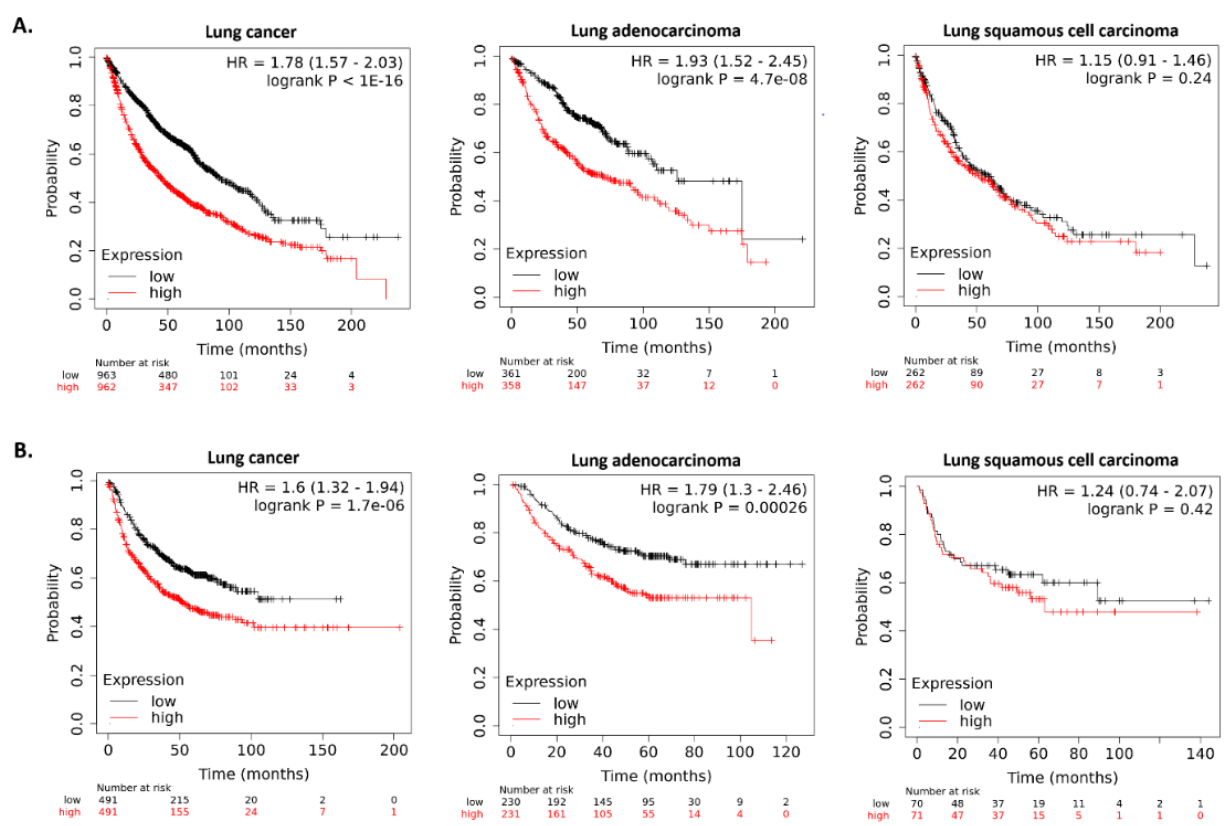
Figure 14. Kaplan–Meier survival curves based on HMGA1 expression level by Kaplan–Meier plotter: ( A ) the overall survival for all lung cancer patients ( n = 1925), lung adenocarcinoma patients ( n = 719), and squamous cell lung carcinoma patients ( n = 524); ( B ) the first progression survival for all lung cancer patients ( n = 982), lung adenocarcinoma patients ( n = 461), and squamous cell lung carcinoma patients ( n = 141). Table 2. HMGA1 expression and survival data of lung cancer patients using the PrognoScan data- base.